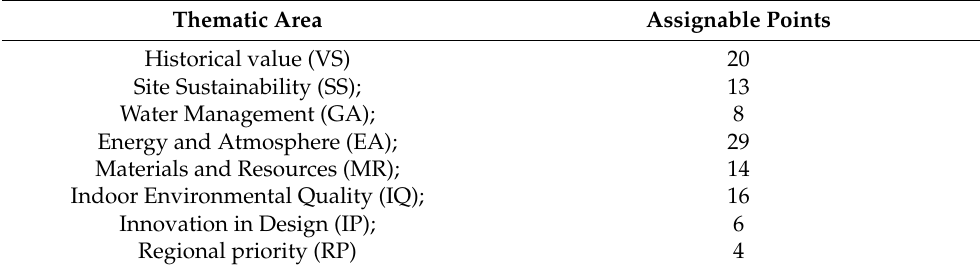
Table 2. Thematic areas (environmental categories) of GBC. Thematic Area Assignable Points Historical value (VS)